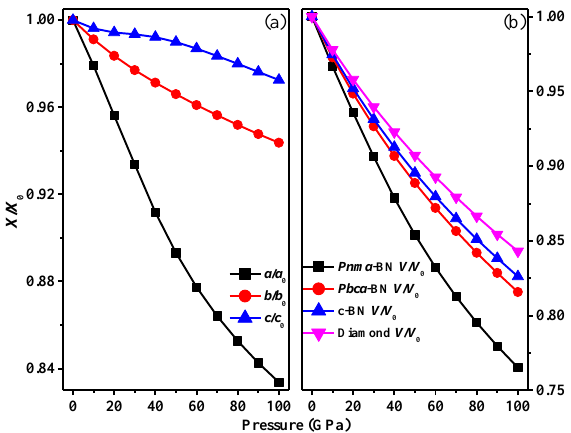
Figure 2. The lattice constants a / a 0 , b / b 0 , c / c 0 compression as functions of pressure for Pnma -BN ( a ), and primitive cell volume V / V 0 for Pbca -BN, Pnma -BN, c-BN, and diamond ( b ).